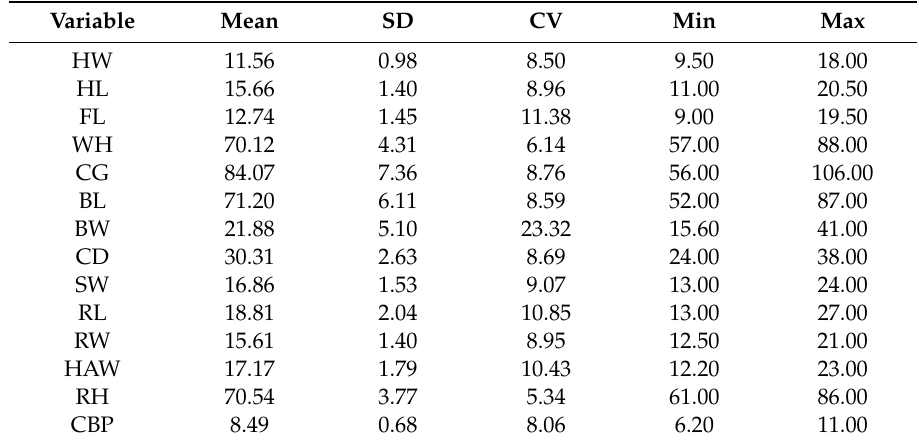
Table 1. Descriptive statistics of the morphometric variables used in Black Creole goats older than one year of age ( n = 226).